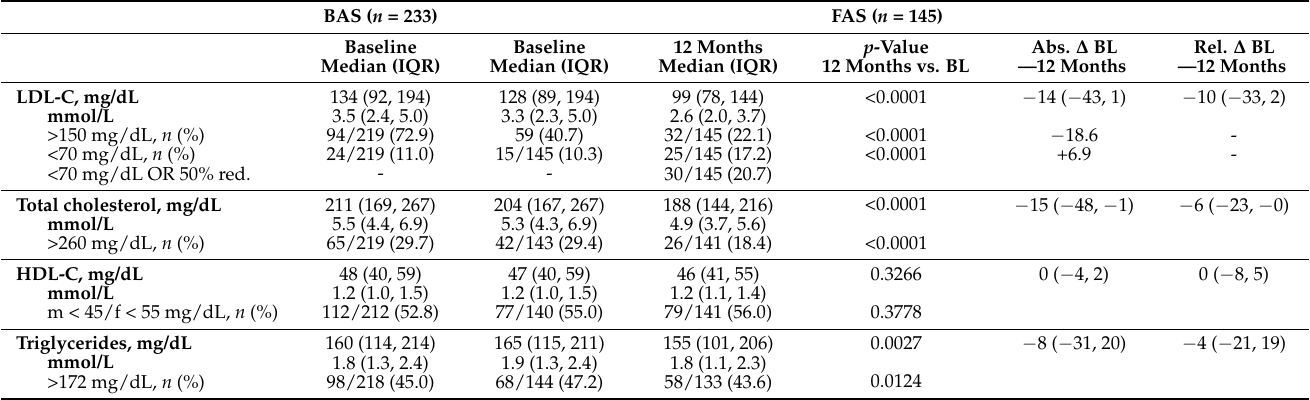
Table 4. Lipid values in the BAS and FAS and change in lipid values in the FAS.